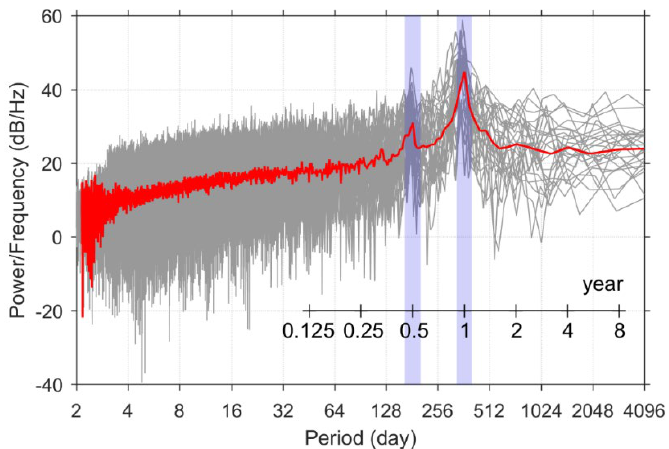
Figure 5. Time series of the power spectral density (PSD) of PWV. Each gray line represents the PSD of a station, and the red line represents the average PSD value.